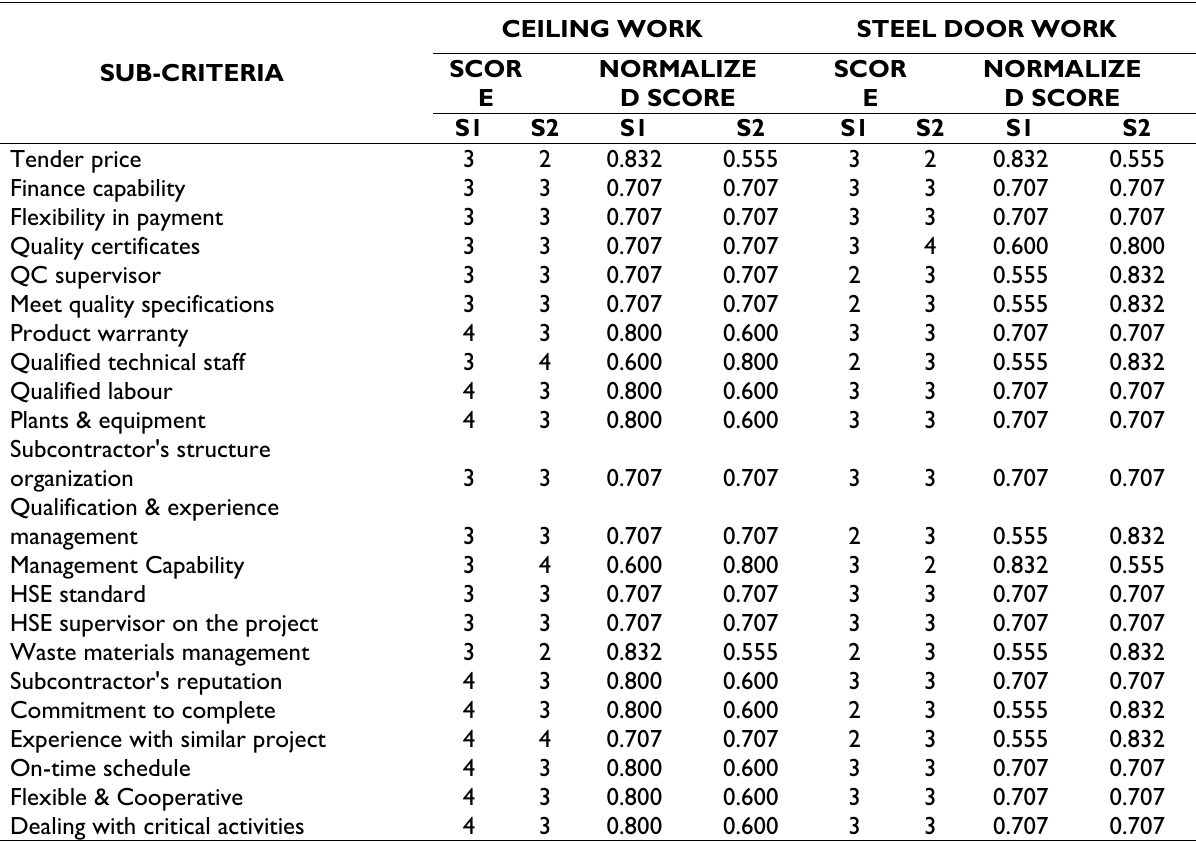
Table 3. Normalized matrix of subcontractor